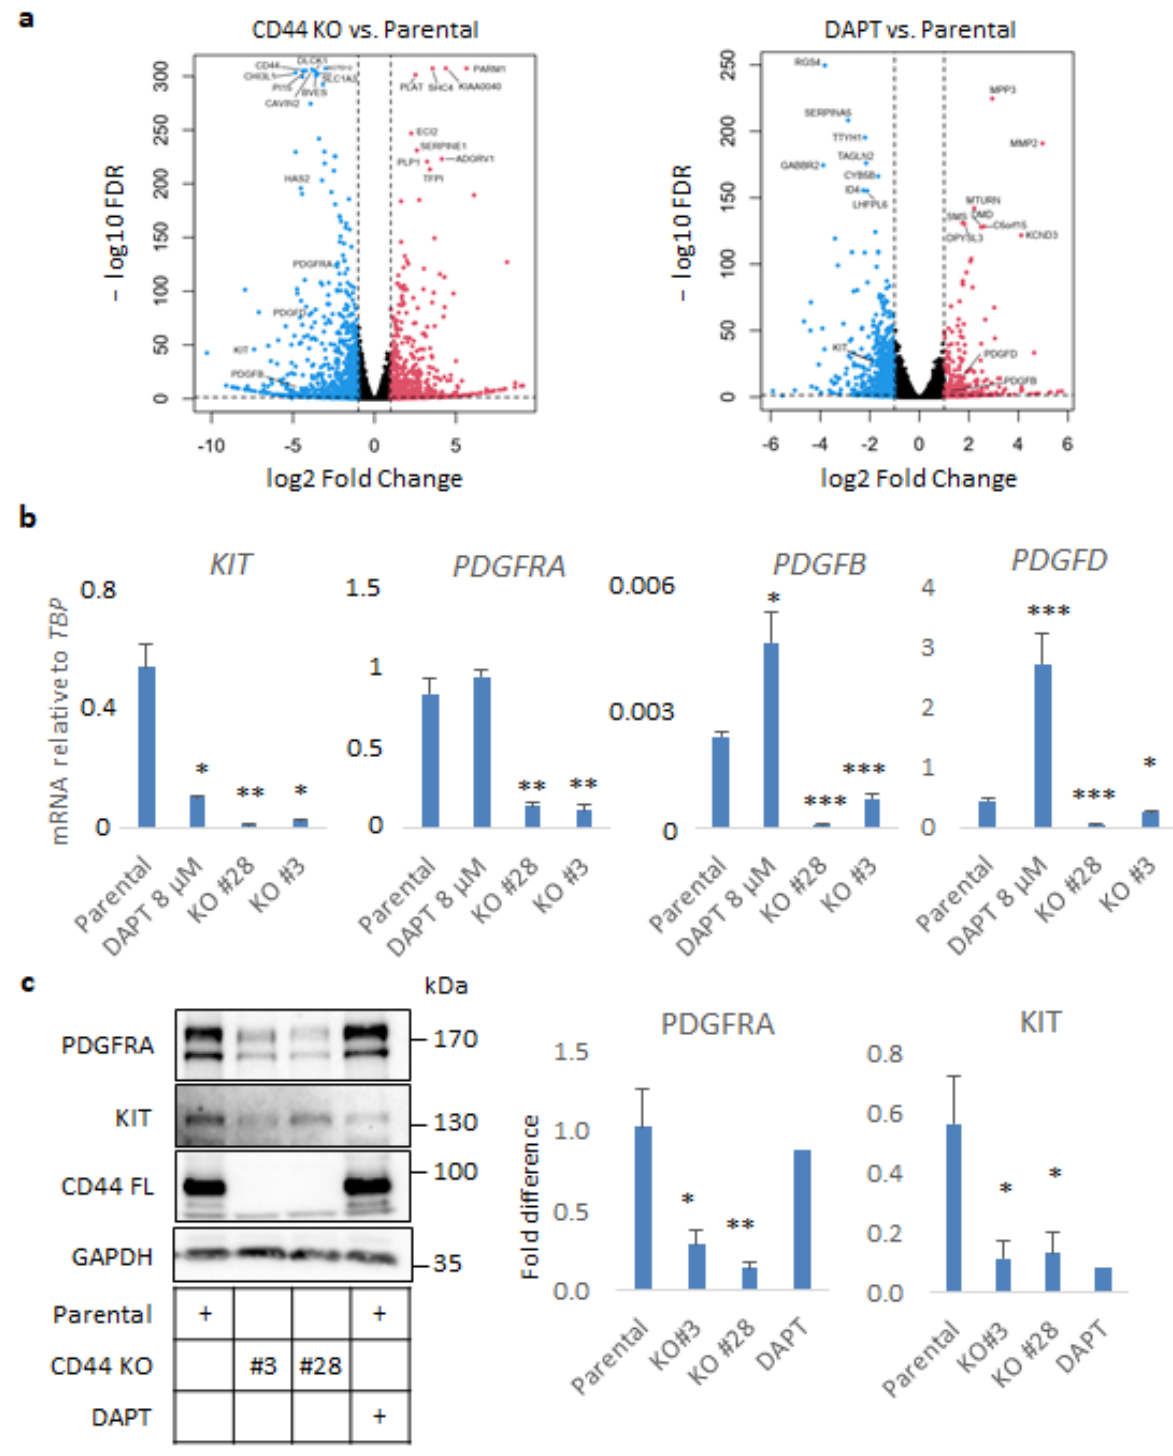
Figure 3. CD44 ablation impairs autocrine PDGF signaling in U251MG cells grown in sphere-like conditions. ( a ) Volcano plots exhibiting differentially regulated genes, which were either down- or upregulated (depicted with blue and red color, respectively) in CD44 KO cells or parental U251MG cells treated with the γ -secretase inhibitor DAPT, compared to the untreated cells. ( b ) mRNA levels of KIT , PDGFRA , PDGFRB , and PDGFD determined by RT-qPCR in spheres formed by parental U251MG cells treated or not with DAPT, and CD44 KO cells, are shown after normalization to TBP. ( c ) Immunoblotting analysis of PDGFRA, KIT, and CD44 was performed using lysates from U251MG cells. GAPDH was used as the loading control. Uncropped immunoblots are depicted in